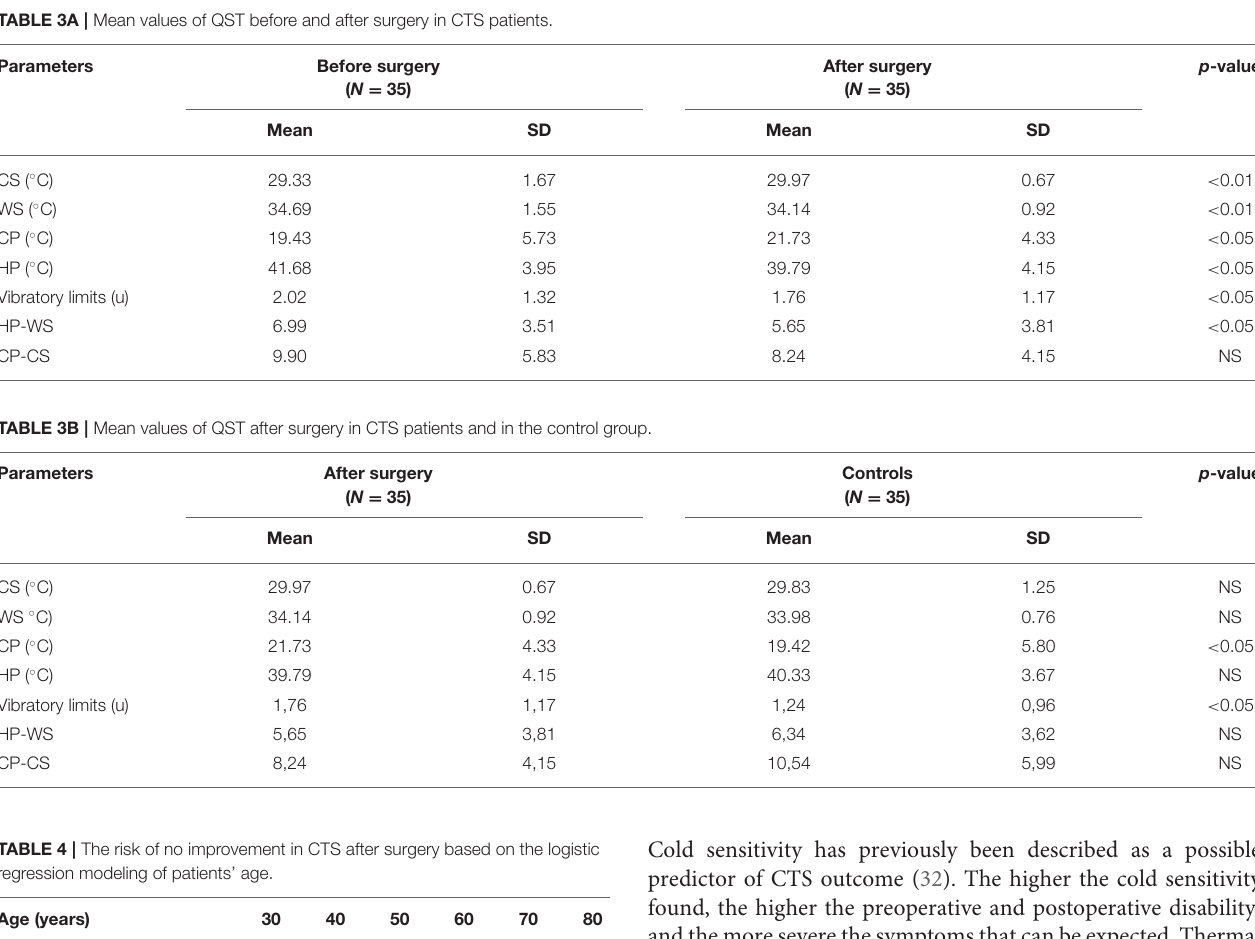
TABLE 4 | The risk of no improvement in CTS after surgery based on the logistic regression modeling of patients’ age. Age (years) Probability of no improvement or deterioration after surgery